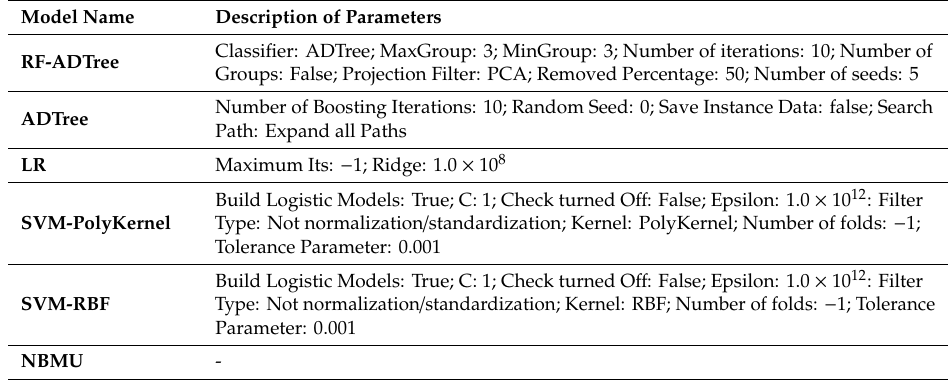
Table 2. Machine learning algorithm used parameters for gully modeling in the Klocheh Watershed, Kurdistan Province, Iran.